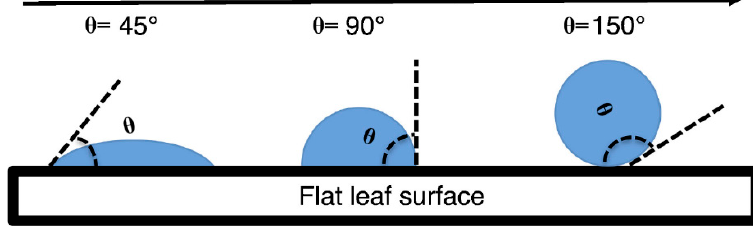
Figure 2. Sketch of contact angle of water droplet and leaf surface.